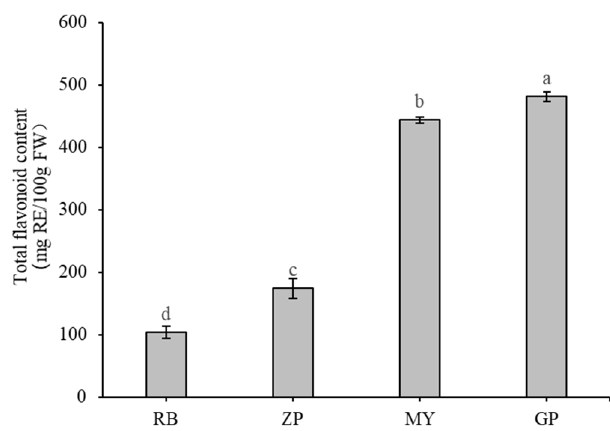
Figure 2. Total flavonoid content of the petals of the four Chaenomeles species. The lower-case letters above the histogram indicate the statistical significance at p <